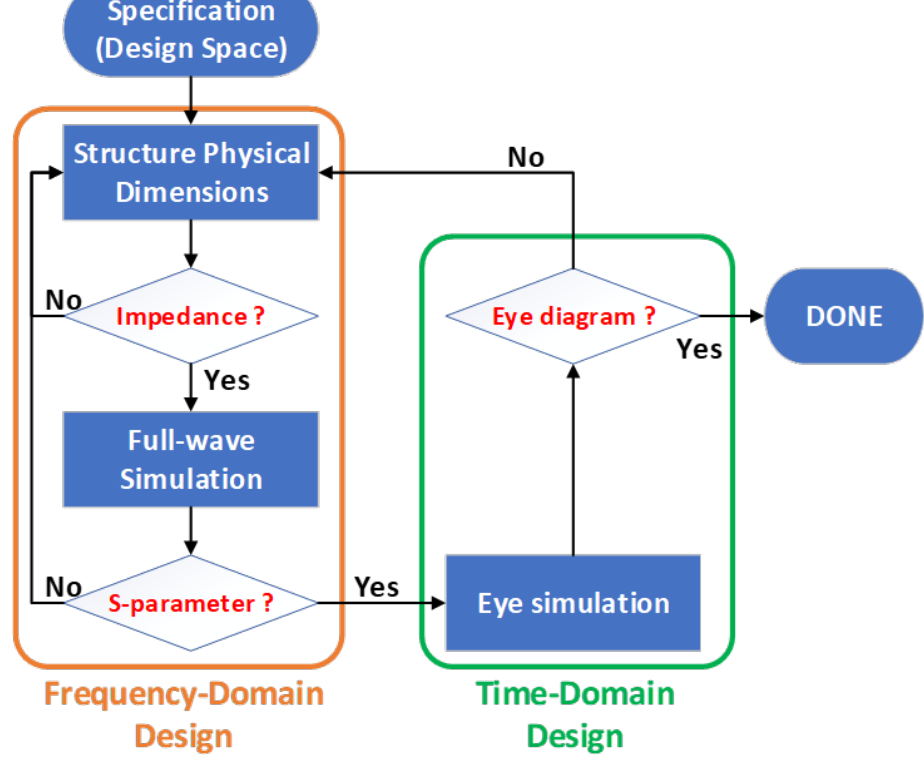
Figure 2. Conventional Design